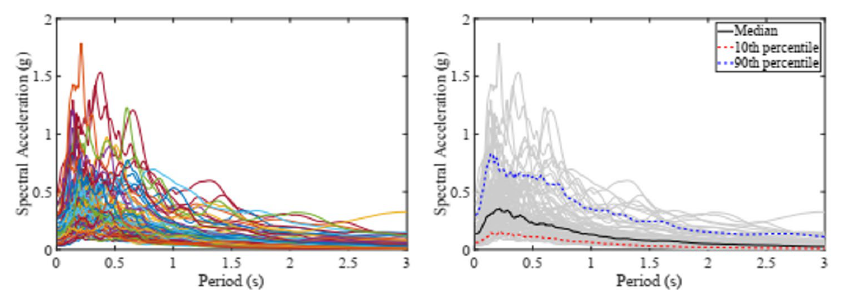
Figure 5. Response spectrum of all records (left) and median, 10th percentile, and 90th percentile of the ground motion suite spectral accelerations (right).